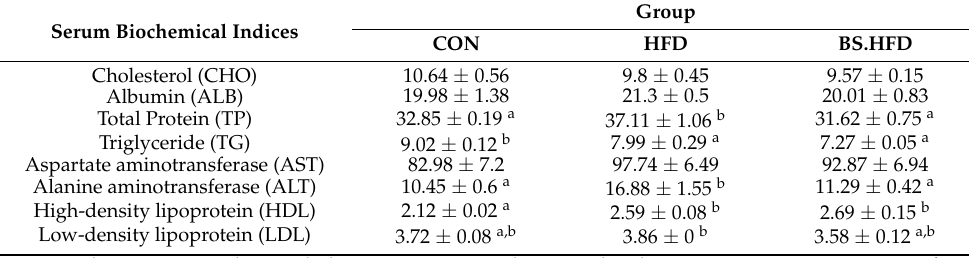
Table 3. Serum biochemical indices of C. idella